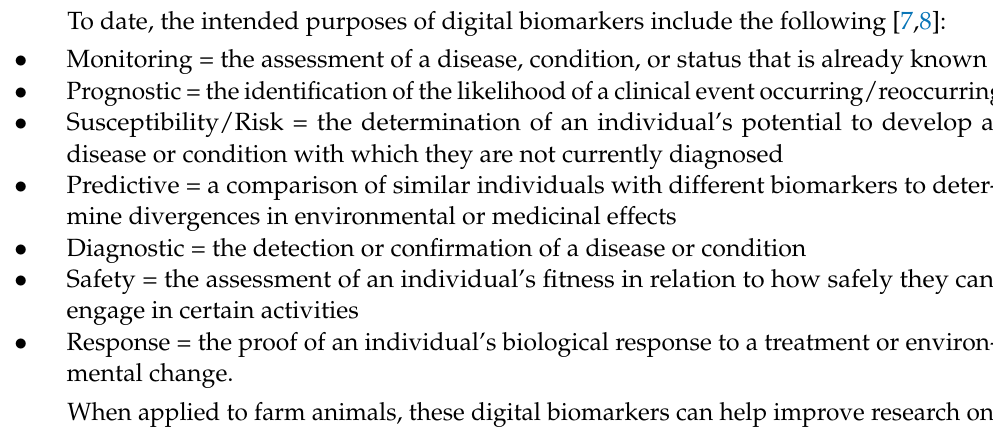
Figure 1. Visual display of digital biomarkers to assess digital phenotyping in farm